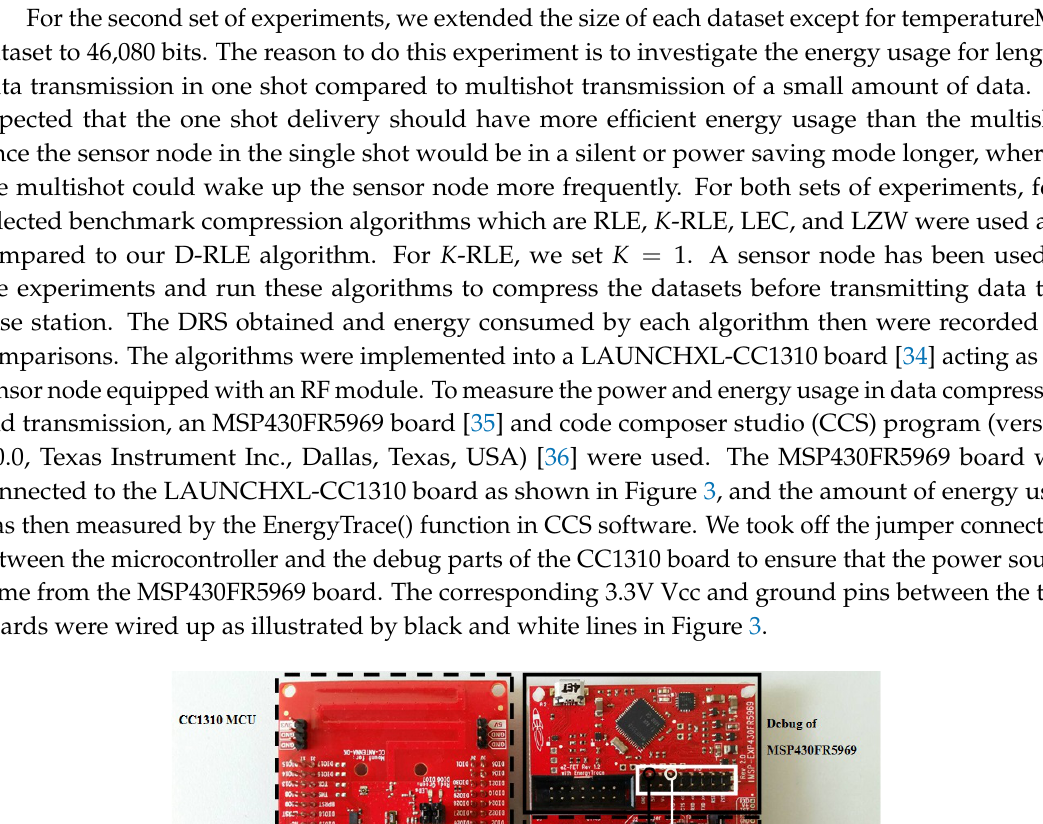
Figure 2. Five datasets used in the experiment. ( a ) sine-like; ( b ) chaotic; ( c ) simulated temperature; ( d ) temperatureHr; ( e ) temperatureMin.